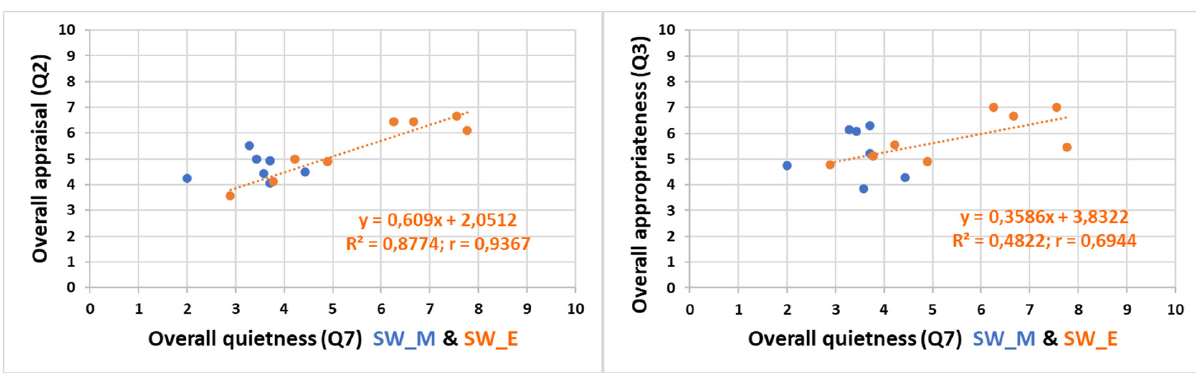
Figure 20: Evening correlation data for Q2 (appraisal, left) and Q3 (appropriateness, right) vs Q7 (quietness) graphed as orange dots and fit equations, compared with morning data (dots in blue) for which there is no correlation